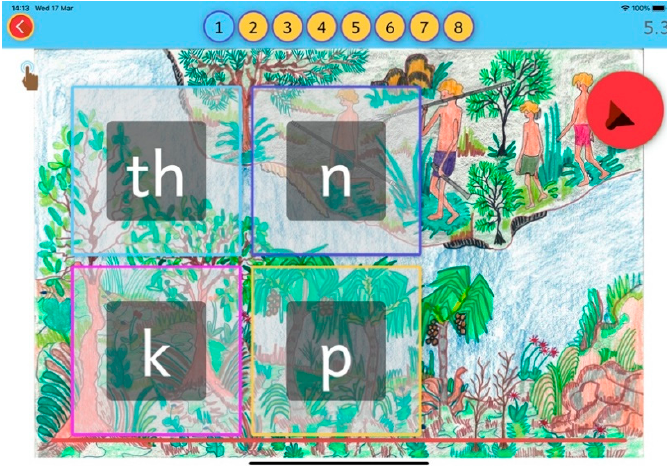
Figure 4. An image from the app (Identifying Letter Sounds).